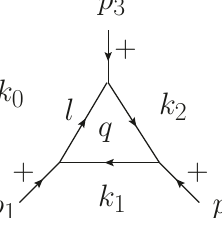
are the external line momenta. i and p = k , p = k , p = k 0 1 1 − k 0 2 2 − k 1 3 0 − k 2